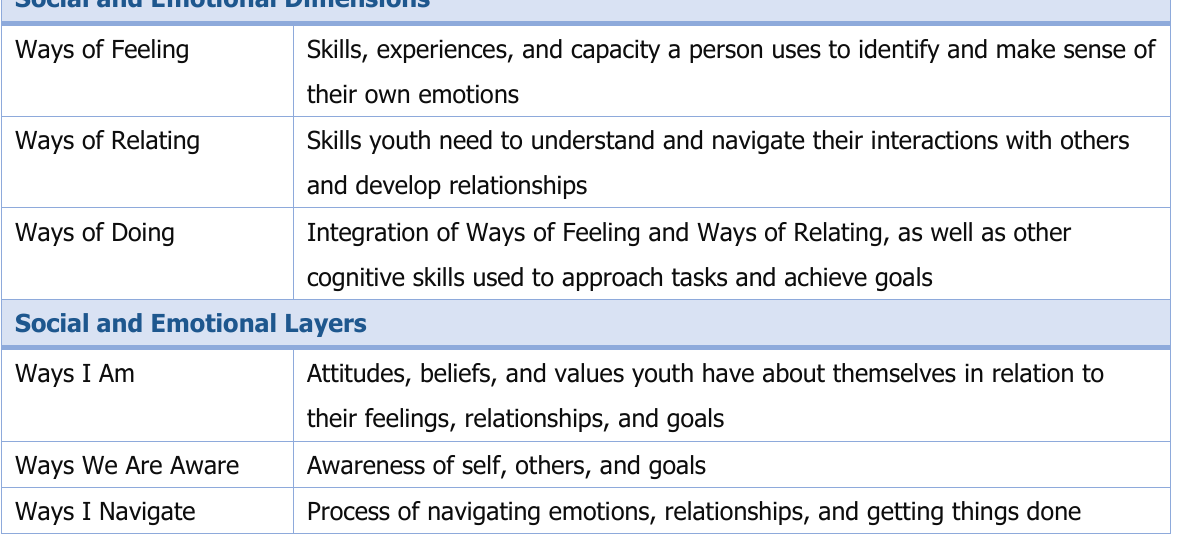
Table 1. Ways of Being: A Model for Social & Emotional Learning (Blyth et al., 2017) Social and Emotional